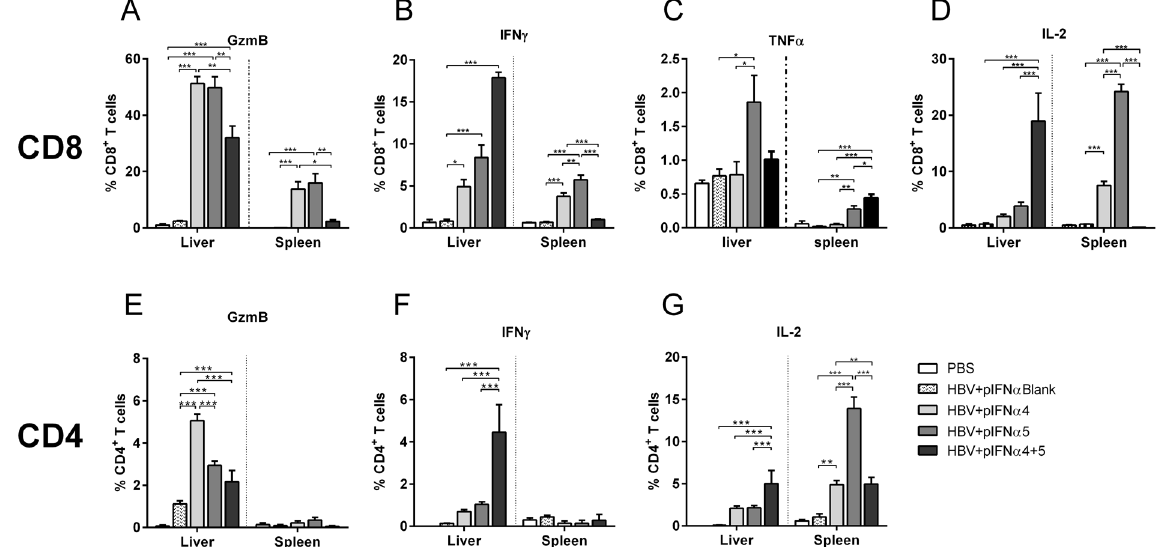
Figure 8. Analysis of CD8 + and CD4 + T cells from pIFN α 4 or pIFN α 5-treated mice. Mice received HI with 10 µ g of pAAV-HBV1.2 plasmids in combination with 20 µ g of plasmids encoding for IFN α subtypes (pIFN α 4, pIFN α 5, pIFN α 4 + 5 or pIFN α Blank (empty vector)). Control mice received HI with PBS (PBS). At day 10 post HI mice were sacrificed and nucleated cells from liver and spleen were analyzed by flow cytometry for expression of T cell specific surface markers and intracellular cytokines. Frequencies of GzmB ( A ), IFN γ ( B ), TNF α ( C ) and IL-2-producing CD8 + T cells ( D ); GzmB ( E ), IFN γ ( F ) and IL-2-producing CD4 + T cells ( G ) are shown. At least four mice per group were analyzed. Differences between the groups were analyzed by using the One-way ANOVA. Statistically significant differences between the groups are indicated by * for p < 0.05, ** for p < 0.01 and *** for p <